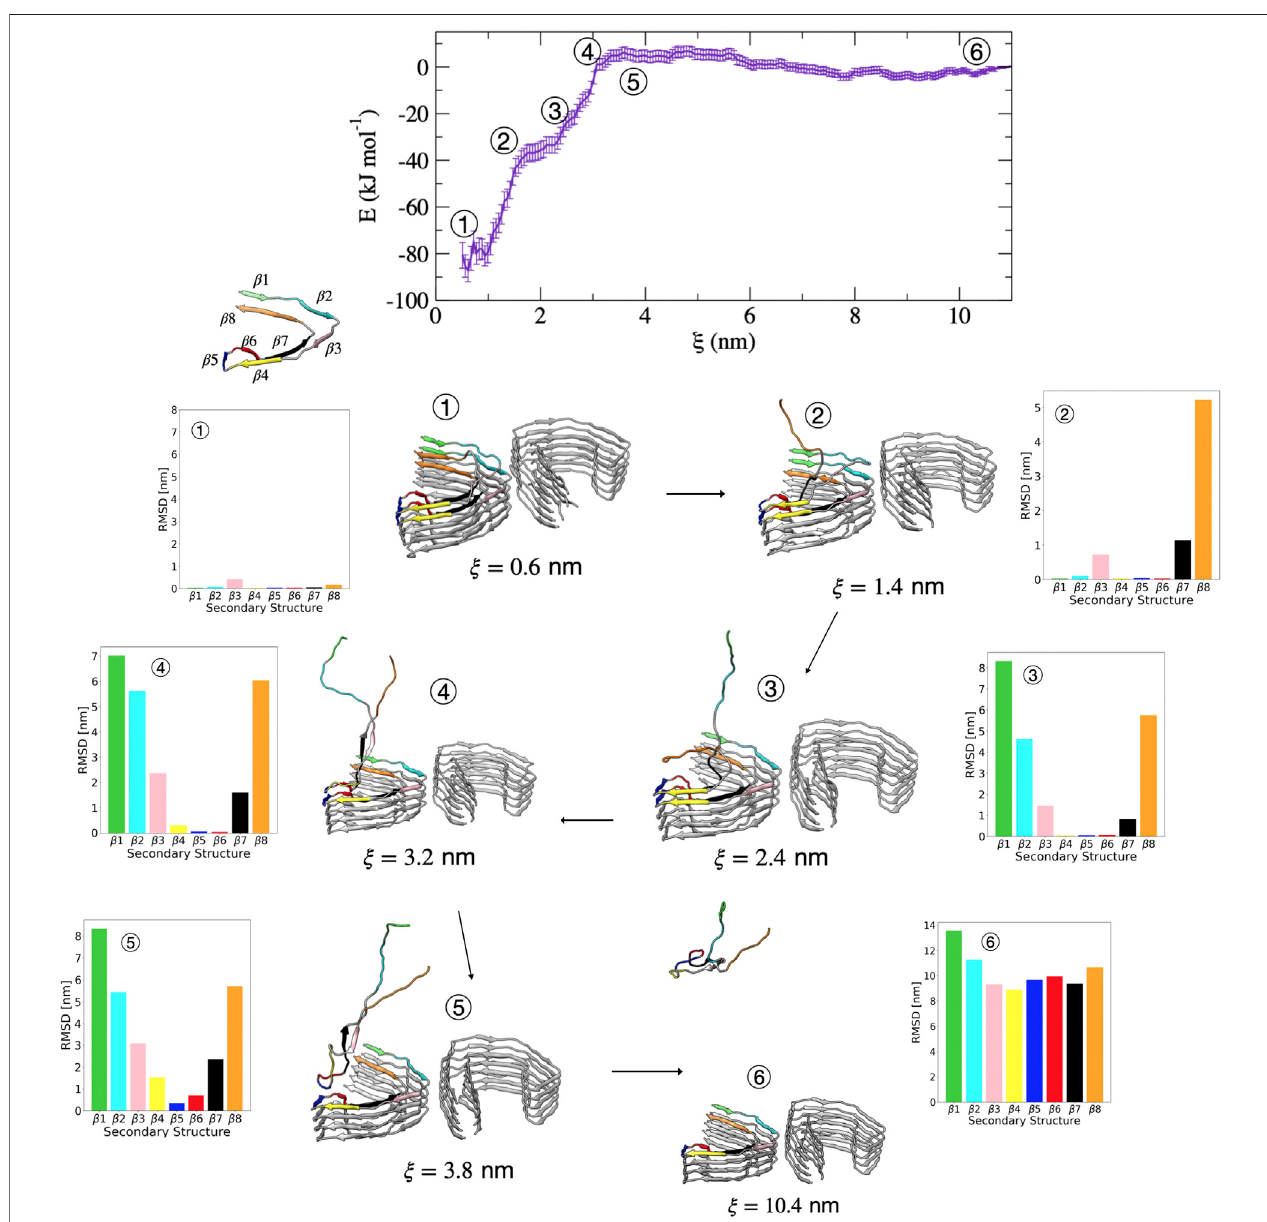
FIGURE 7 | Free energy pro fi le for the association/dissociation of a single tau chain onto the SF proto fi bril. Representative structures are shown along with the dRMSDofthesecondarystructure regions. Taudissociatesstartingfrom the β 8end,shown bytheincreaseindRMSD betweenstructures1and 2for β 7(black)and β 8 (orange). Structure 3 shows simultaneous loss of β 1 (green) and β 2 (cyan). Structure 4 shows simultaneous loss of β 3 (pink) and β 7 (black). Structure 5shows loss of β 4 (yellow) and anincreaseddRMSDfor β 6(red). Thecomplete dissociationoccurswithlossof β 5(blue).Structureswereobtainedfromumbrellasamplingsimulation window within the different regions along the reaction coordinate after 5 ns. The dRMSD values in each of the bar graphs are calculated from Eq. 1 for the depicted representative structures taken at 5 ns of simulation, where the fi nal folded state is the reference structure.